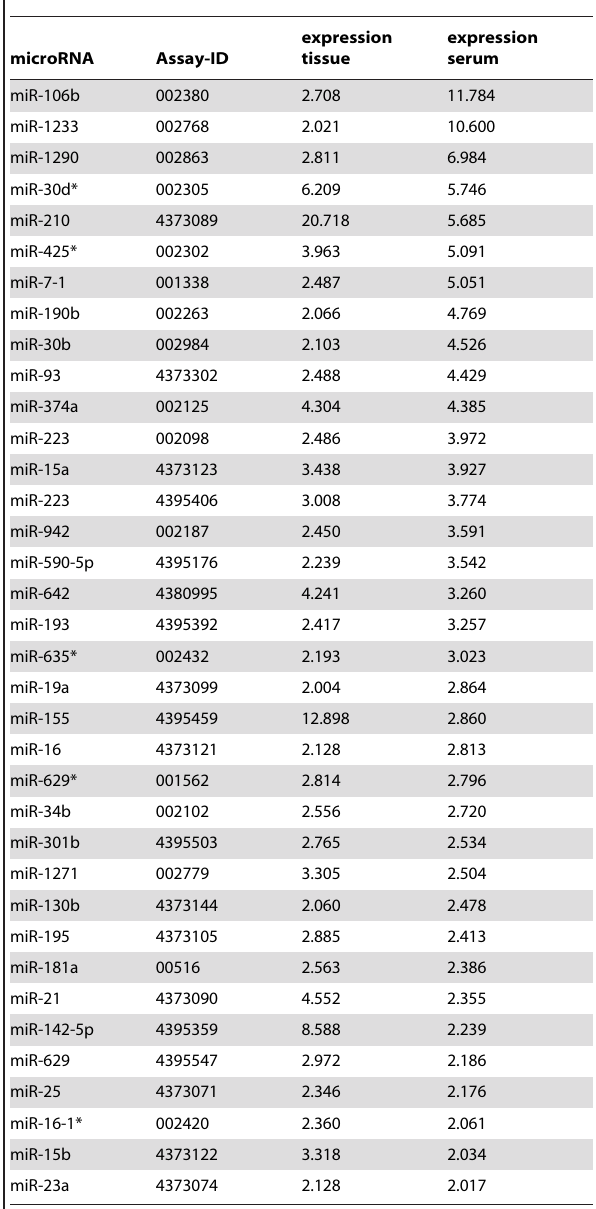
Table 2. MicroRNAs with . 2-fold overexpression in serum and tissue of renal cell carcinoma